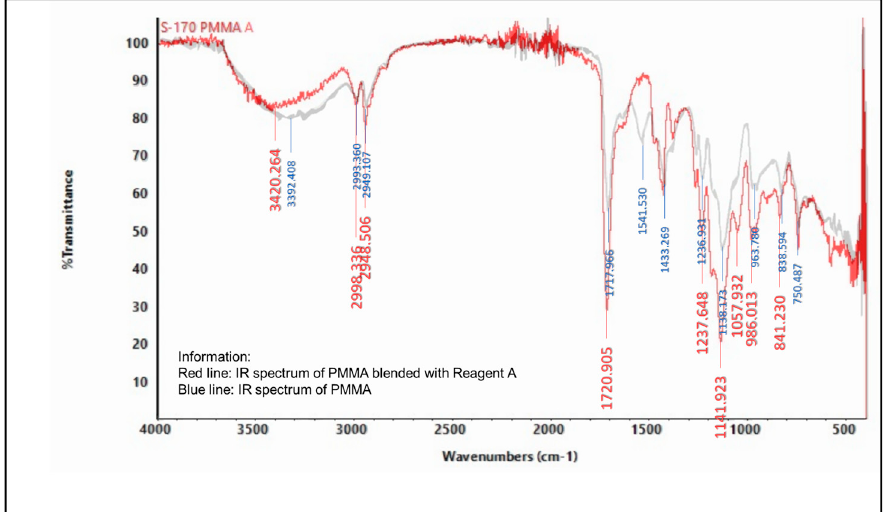
Figure 4. IR spectrum comparison of pure PMMA and blended PMMA with reagent A (concentrated H 2 SO 4 ).